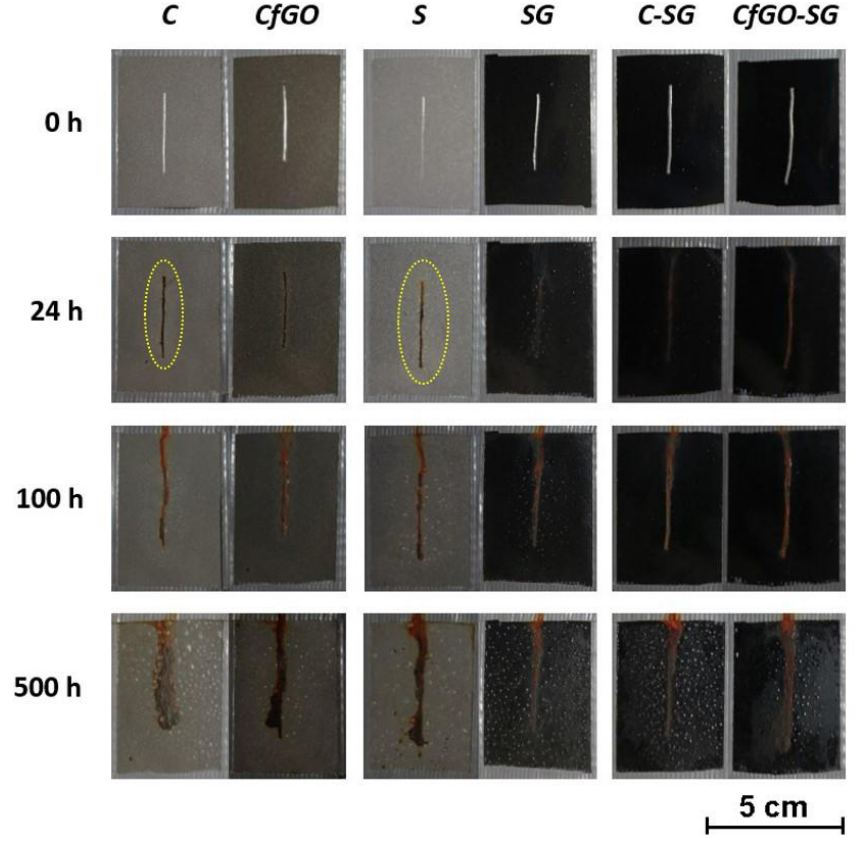
Figure 5. Coatings degradation during samples exposure in salt spray chamber.